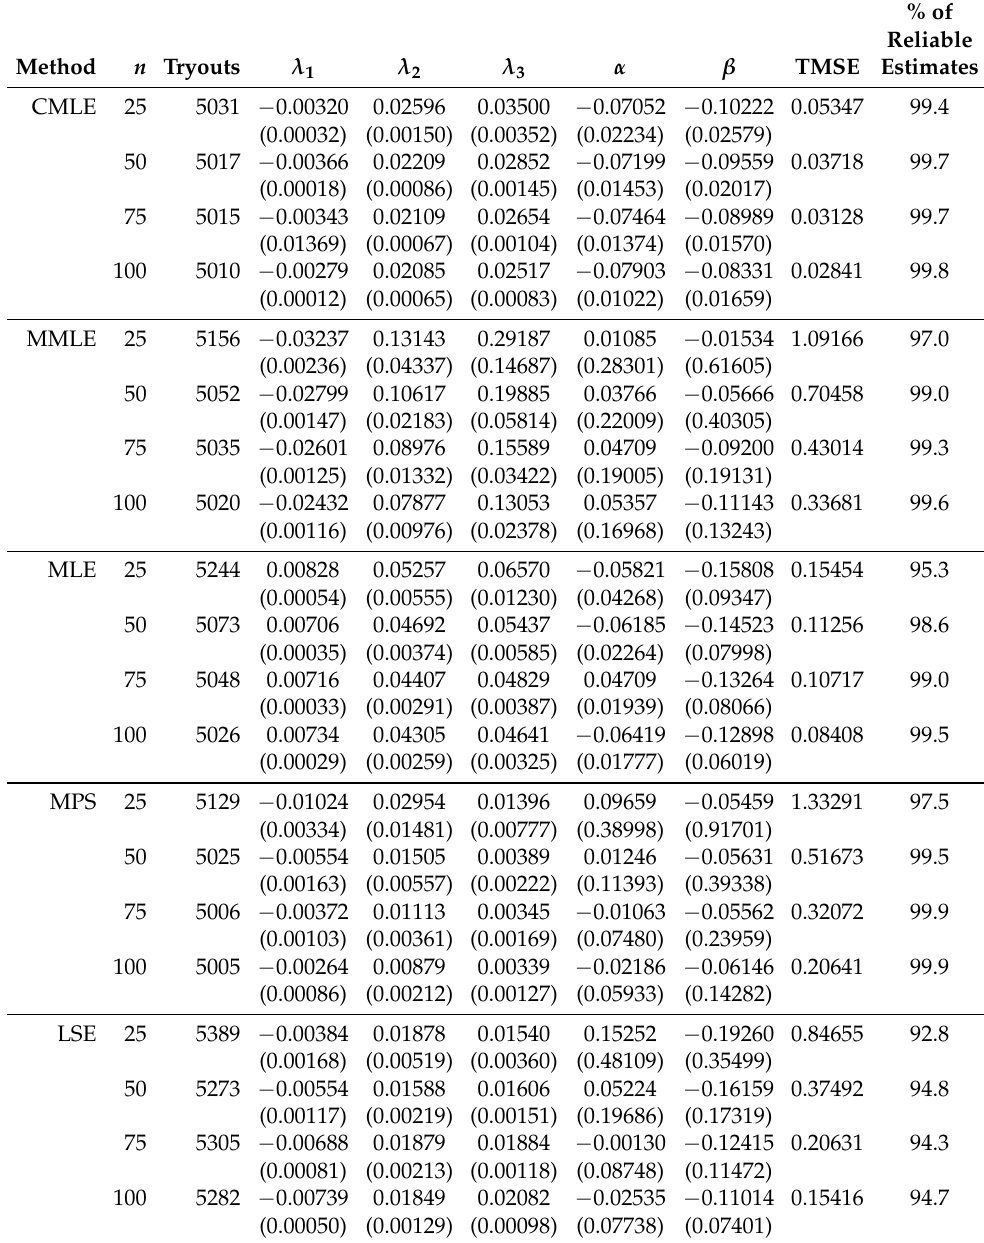
Table 2. Simulated biases and MSEs (in parentheses) of the parameter estimates obtained based